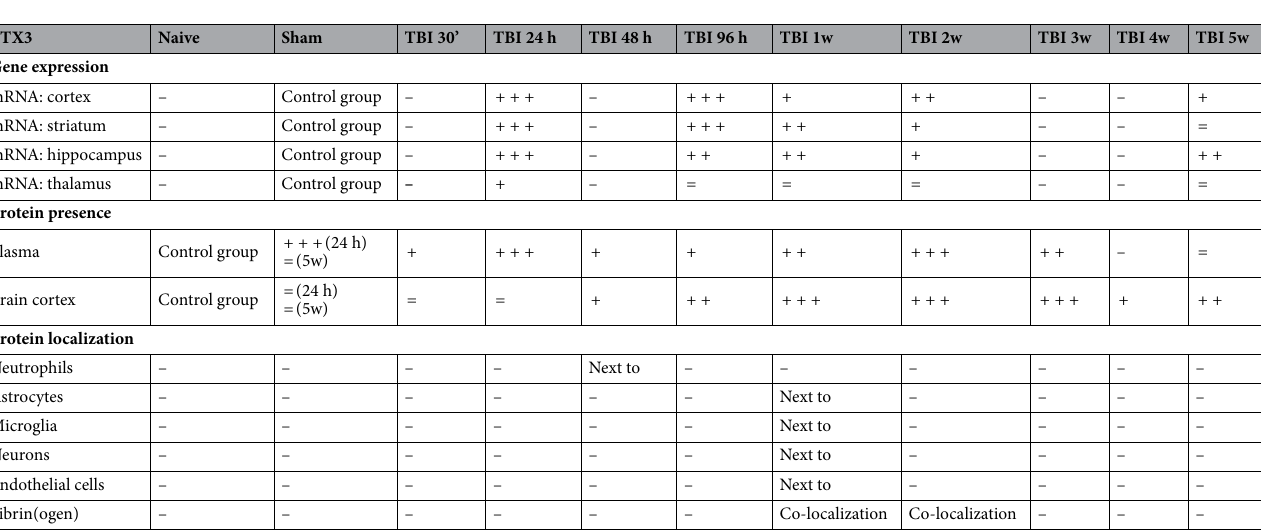
Table 1. Summary table of brain PTX3 mRNA expression, protein presence and localization over time after TBI. The long-lasting pattern of activation of PTX3 in brain and blood following TBI supports the hypothesis that PTX3 contributes to the progression of the lesion with effects varying over time. Increases versus respective controls are calculated according to quartiles and correspond to: = control group; + low increase; + + intermediate increase; + + + high